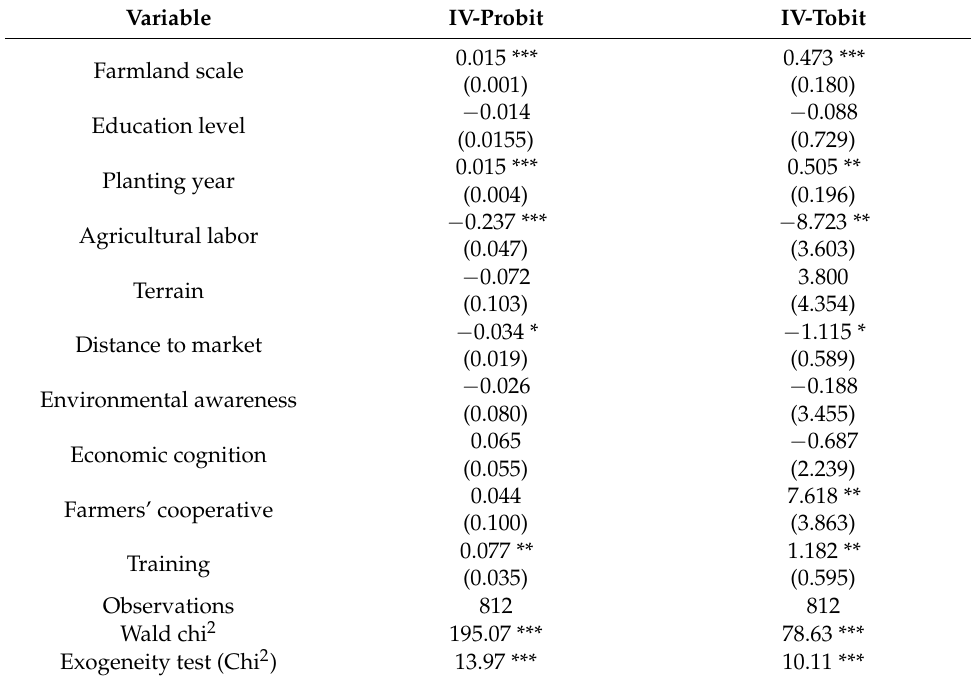
Table 4. Estimation results of IV-Probit and IV-Tobit.